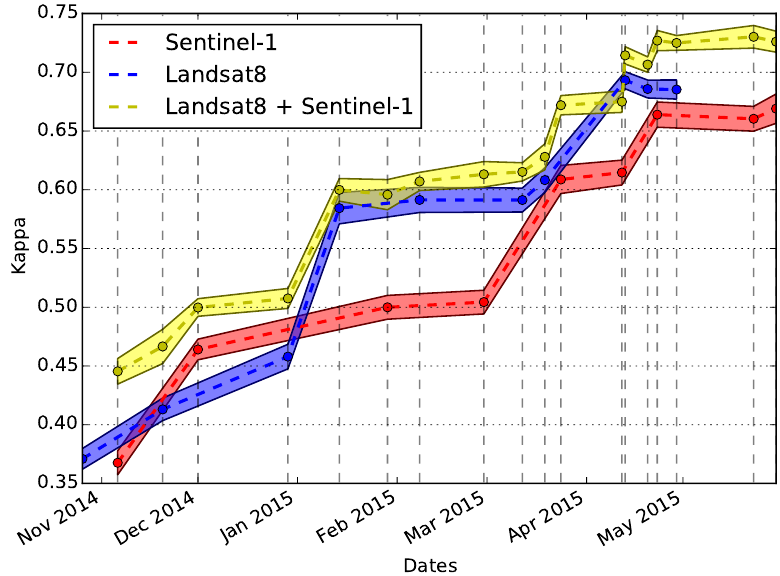
Figure 4. Kappa coefficient of the real-time classification simulation for 3 scenarios with 95% confidence